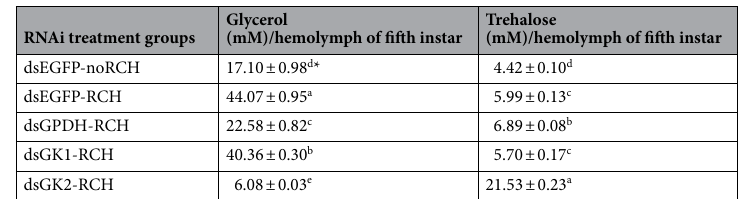
Table 1. Change polyol content in Spodoptera frugiperda fifth instar hemolymph in response to exposure to 5 °C. Each treatment was replicated three times with 10 individuals per replication. *Different superscript letters indicate significant difference between means for each polyol (Type I error = 0.05, LSD test).